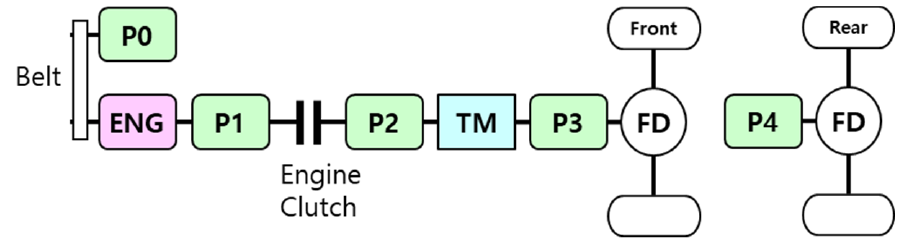
Figure 2. Parallel HEV structures classification.